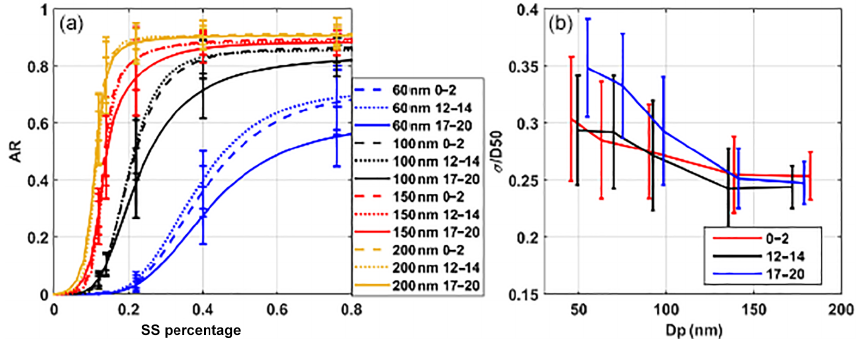
Figure 3. (a) Averaged fitted CCN efficiency spectra during the nighttime period (00:00–02:00LT, dashed lines), the noontime period (12:00– 14:00LT, dotted lines), and the evening rush hour period (17:00–20:00LT, solid lines) for different diameters (60, 100, 150, and 200nm).